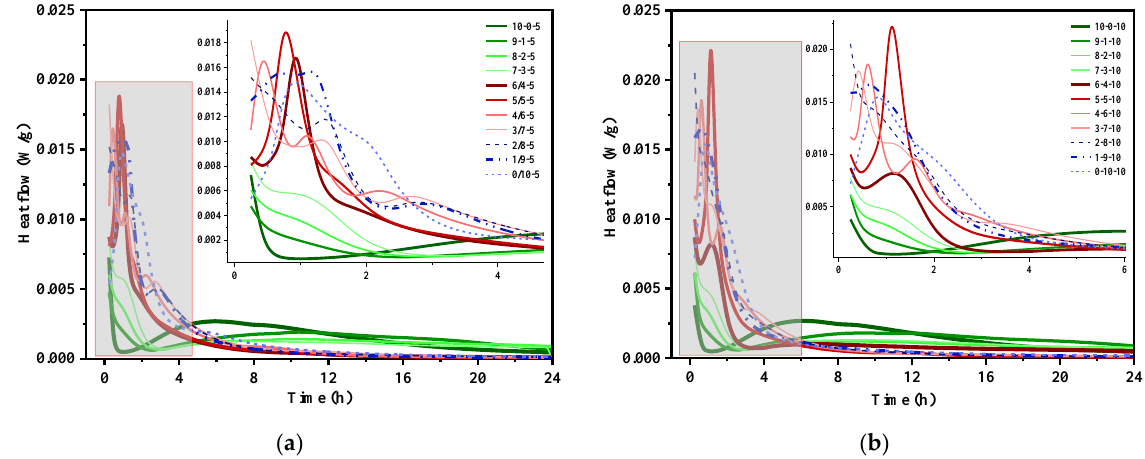
Figure 4. Hydration heat flow of OPC-CSA- CS ternary blends with different CS contents: ( a ) with 5% CS; ( b ) with 10% CS.